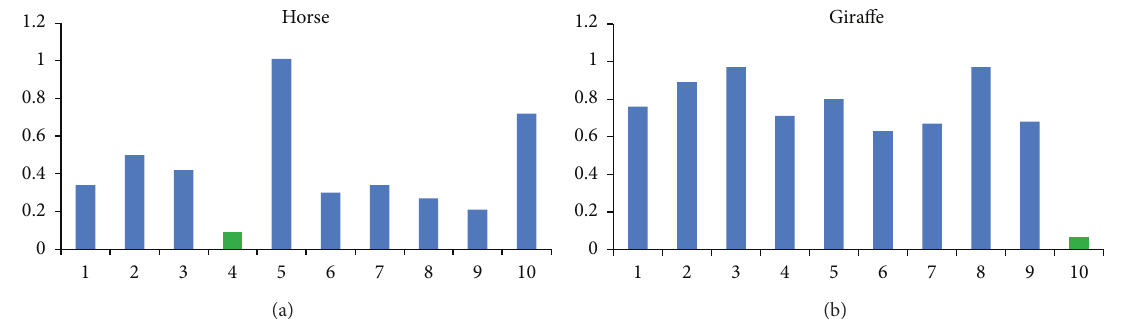
Figure 13: The Euclidean distances values of MWD calculated from the approximation signal.